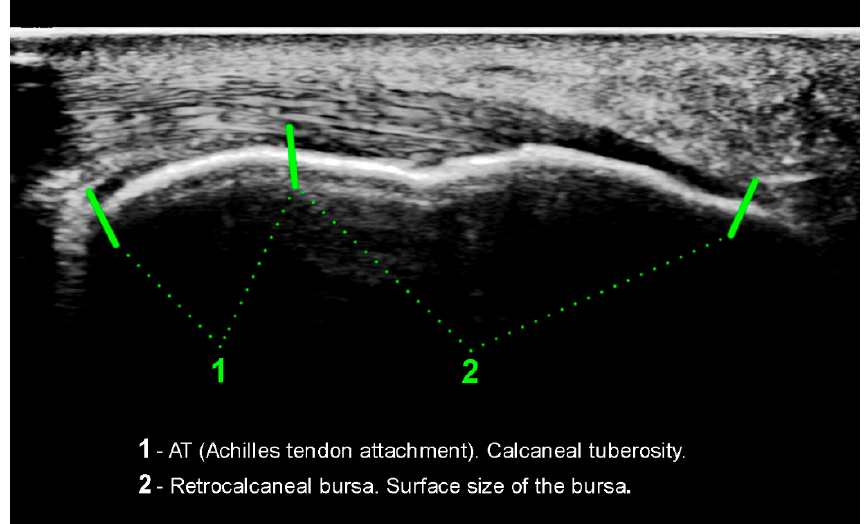
Figure 4. Ultrasonographic image presenting the bursa size measurement.